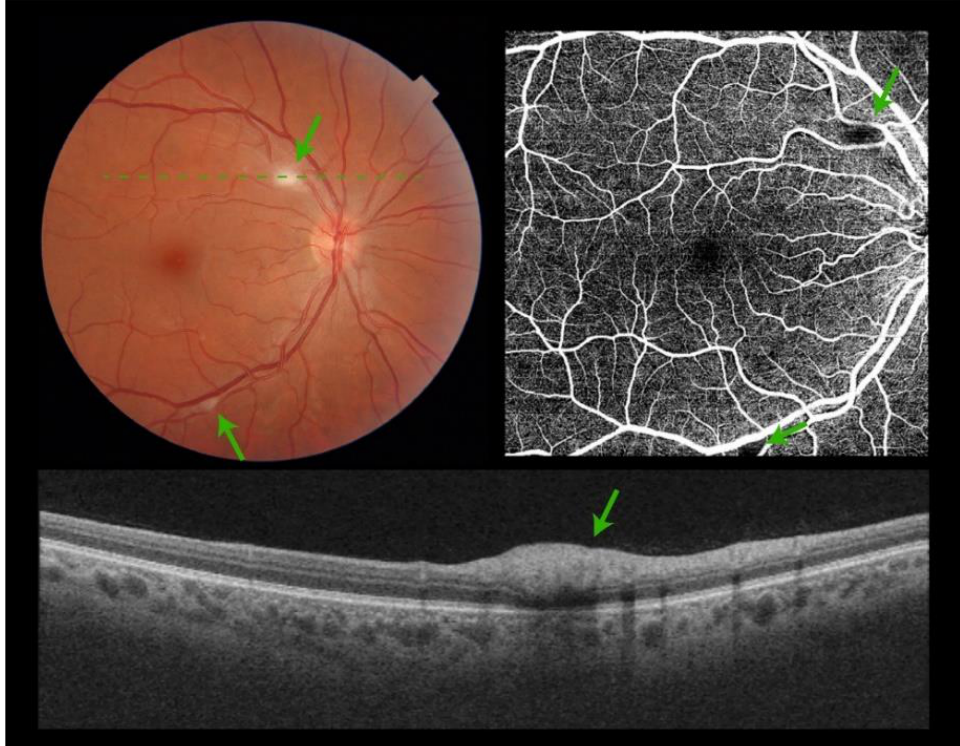
Figure 1. Composite figure. Color picture showing the right eye retina of a patient admitted to hospital with acute SARS-CoV-2 infection. Two isolated cotton wool spots are visible at the posterior pole ( green arrows ). No other signs of retinopathy can be detected ( top left ). Optical Coherence Tomography Angiography showing a black shadow ( green arrows ) at the areas of the cotton wool spots. No other microvascular pathology can be identified ( top right ). Optical Coherence Tomography scan over the cotton wool spot ( green dashed line ) showing hyperreflectivity of the inner retinal layers ( bottom ).